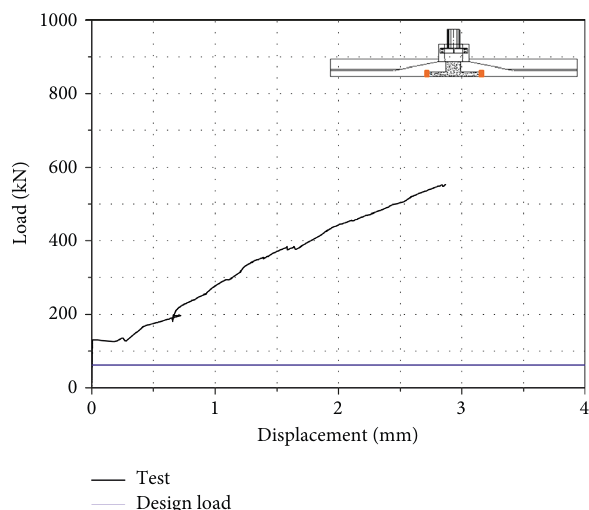
Figure 9: Load-crack displacement relationship at